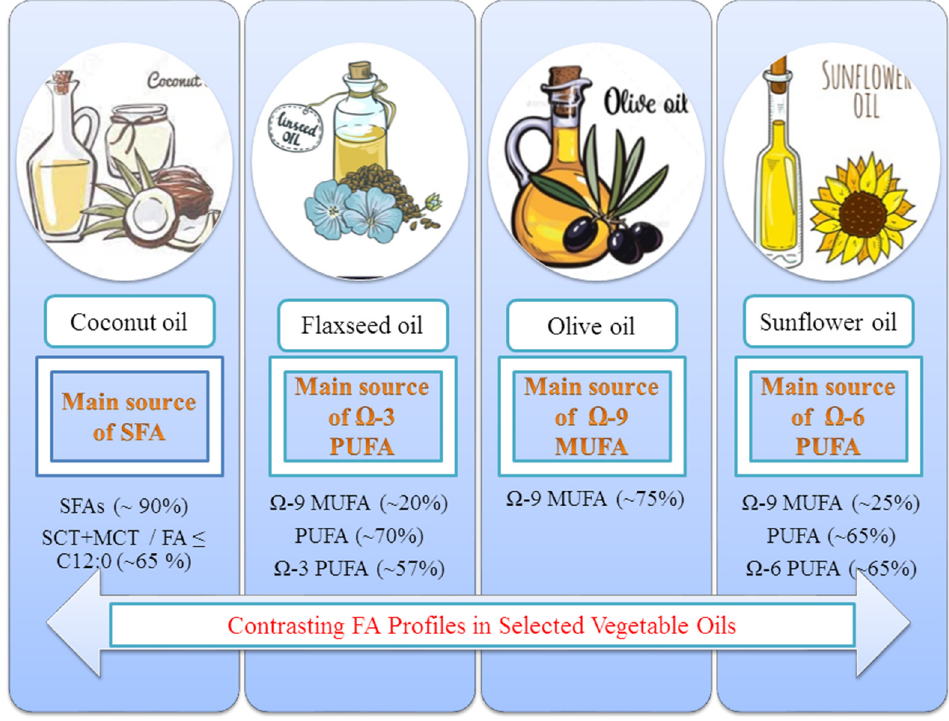
Figure 1. Selected vegetable oils with contrasting fatty acid profiles.